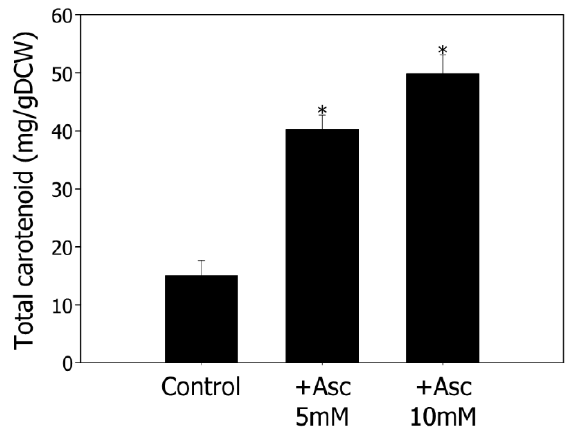
Figure 4. Measurement of total carotenoid contents in the presence of ascorbic acid under MES conditions. Asc, ascorbic acid. Experiments were performed in triplicate and error bars indicate standard deviation of mean. Asterisk represent statistically significant difference, as determined by a Student’s t ‐ test (* p < 0.05).